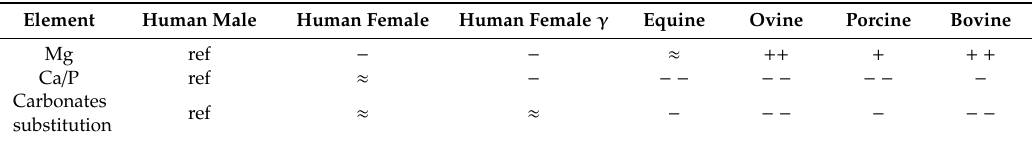
Table 4. Overview of the main characteristics of the investigated specimens. All values are compared to male human bone (reference), and di ff erences are visually indicated in terms of sign (higher / lower / similar: +/ − / ≈ ) and magnitude ( +/++ , − / − −